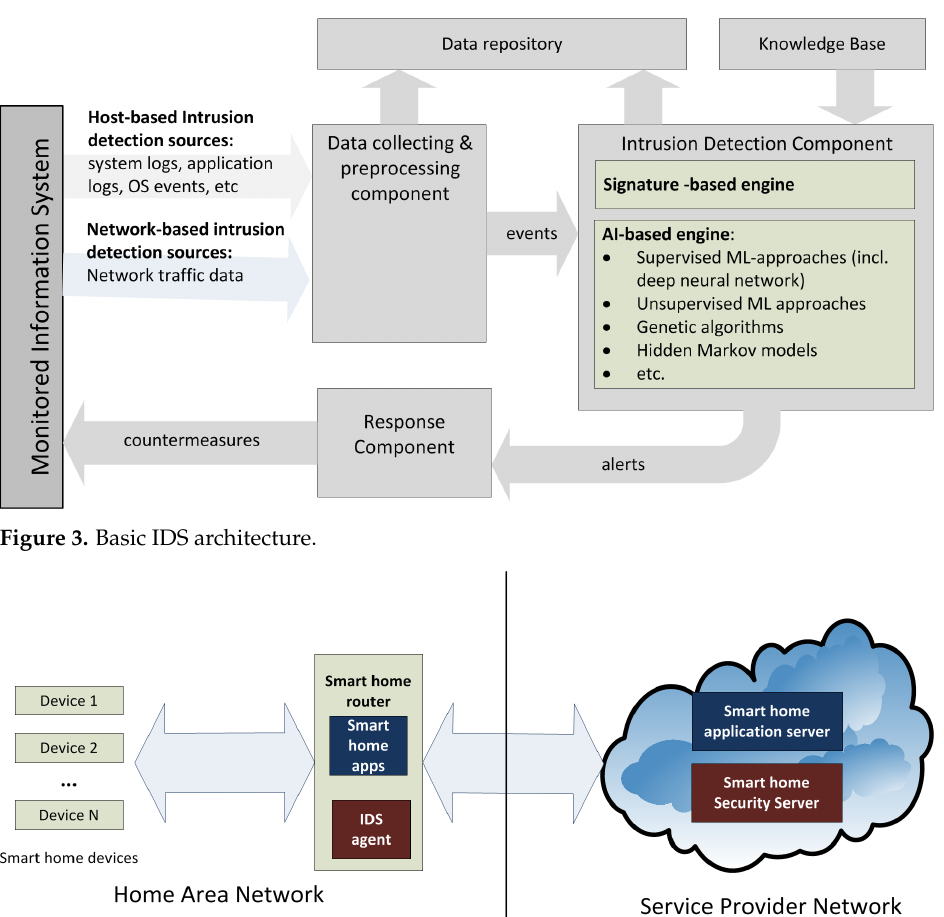
Figure 4. The high-level overview of the hierarchical distributed IDS for Smart Home